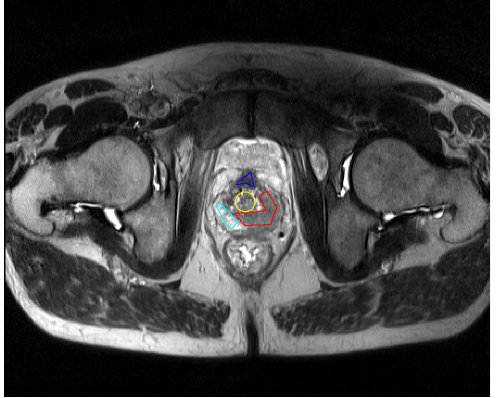
Figure 11. Initialization used for the testing of all the